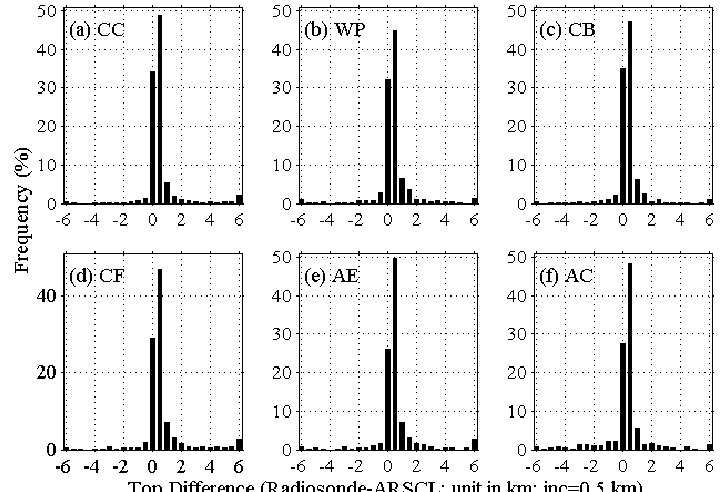
Figure 10. Histogram of difference of collocated cloud-top heights derived from the radiosonde and ARSCL data in the synoptic patterns of: CC ( a ); WP ( b ); CB ( c ); CF ( d ); AE ( e ); and AC ( f ) during 2001–2010 at the SGP site. The space interval is 0.5 km in each panel.